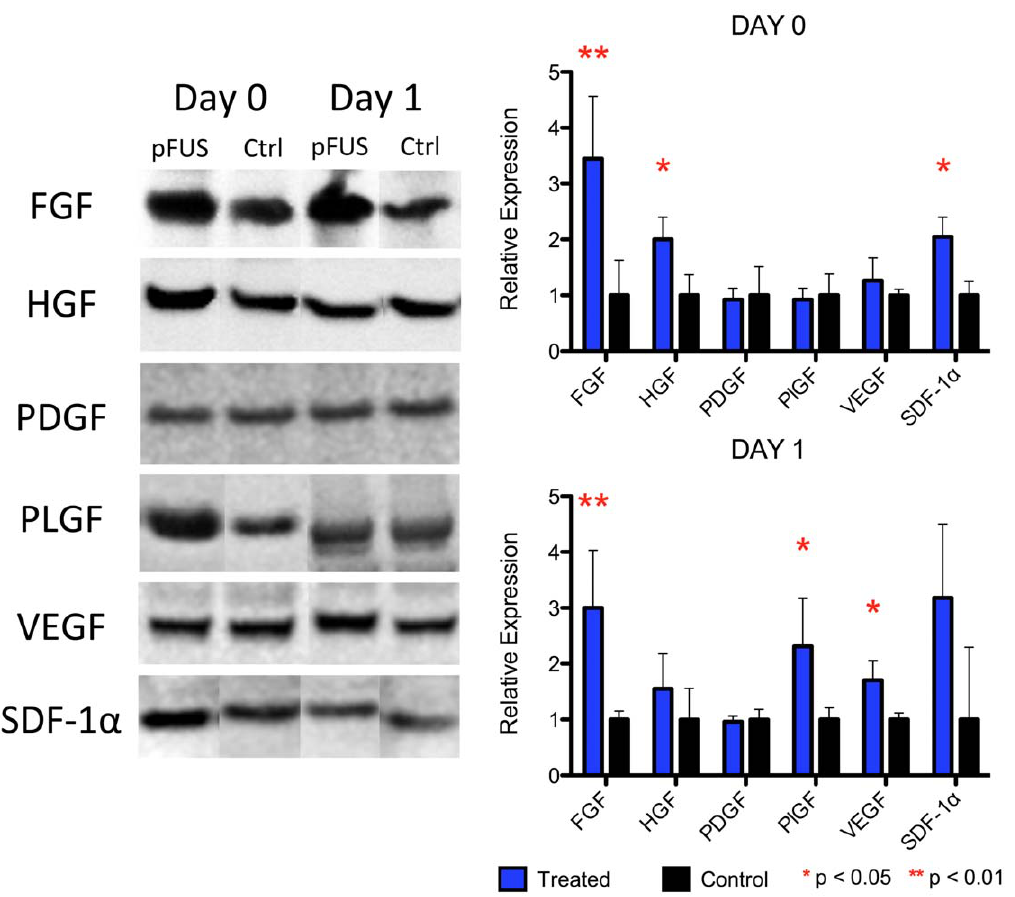
Figure 8. Expression of growth factors on days 0 and 1 following pFUS treatment. Western blotting was used to compare growth factor expression in pFUS-treated muscle compared to muscle from the untreated contralateral leg (n=5).